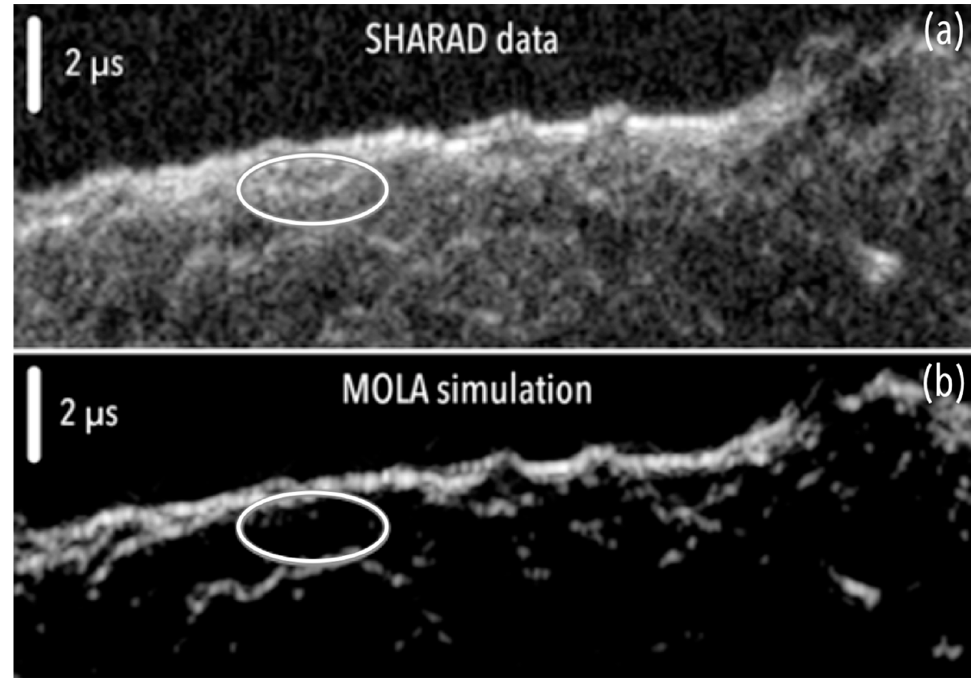
Figure 5. ( a ) A 65 km portion of the SHARAD profile n°5128501; ( b ) corresponding simulation using a MOLA DTM. The reflector circled in white is present in the SHARAD data but not in the MOLA simulation.